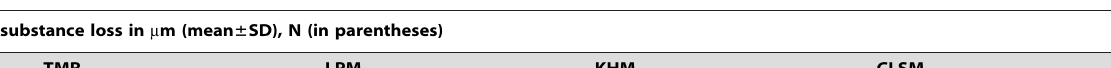
Erosive substance loss in m m (mean ± SD), N (in parentheses)